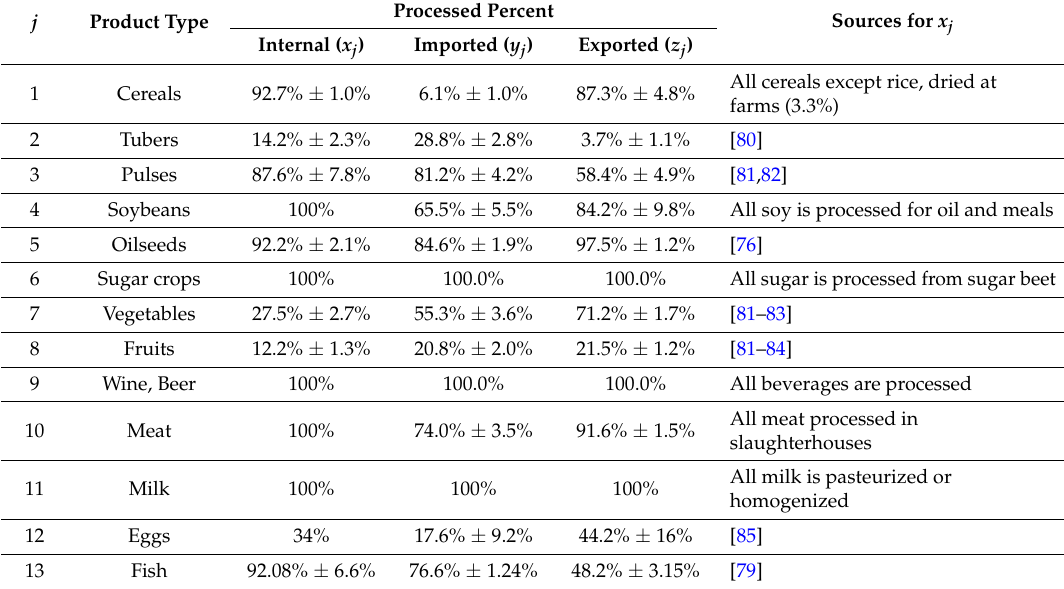
Table 2. Percent of processed food in Italy ( x j and z j ) or abroad ( y j ) for different product types. In row 10 the processed percent of exported and imported meat is less than 100%, because the remaining part (unprocessed meat) is constituted by live